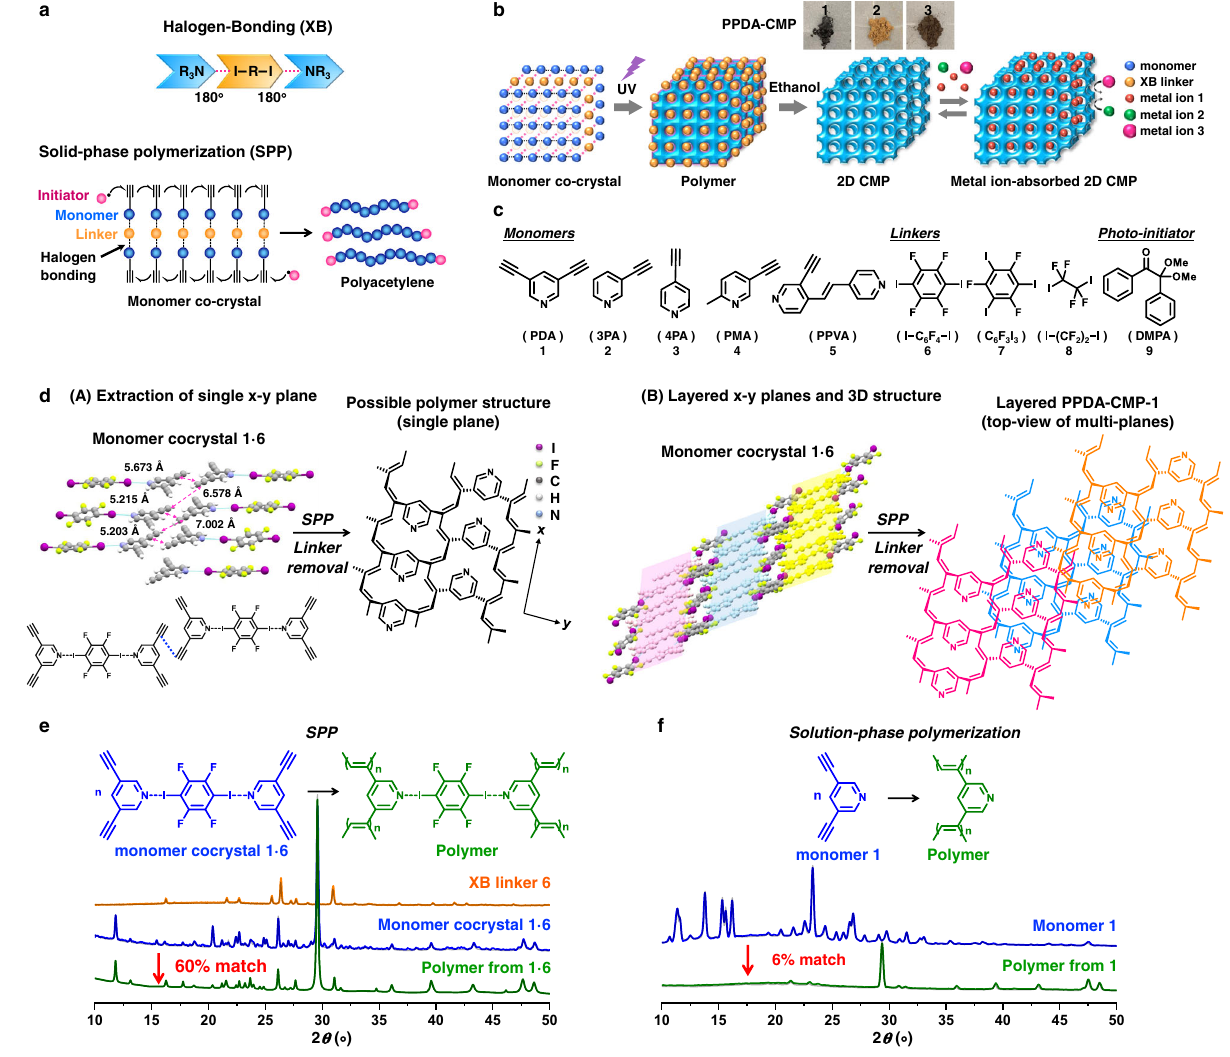
Fig.1|SchematicillustrationofXB-assistedSPP,compoundsusedinthiswork, monomer cocrystal and polymer structures, and PXRD patterns before and after polymerization. a Schematic illustration of XB-assisted SPP of acetylene. b Schematic illustration of polyacetylene synthesis, 2D CMP formation after linker removal, and metal ion adsorption of 2D CMP. The inserted photos show PPDA- CMP-1, 2, and 3 generated from monomer cocrystals 1·6 , 1·7 , and 1·8 , respectively (after linker removal). c Monomers, linkers, and photo-initiator used in this work. d ( A ) Monomer cocrystal structure of 1·6 determined by single-crystal X-ray dif- fraction and a possible polymer structure expected from the monomer cocrystal structure. The fi gure extracts a single x - y plane of the monomer cocrystal and its possible polymer structure, which is a ladder-shaped polymer growing on the x -axis. The ladder-shaped polymer is further connected to the neighboring